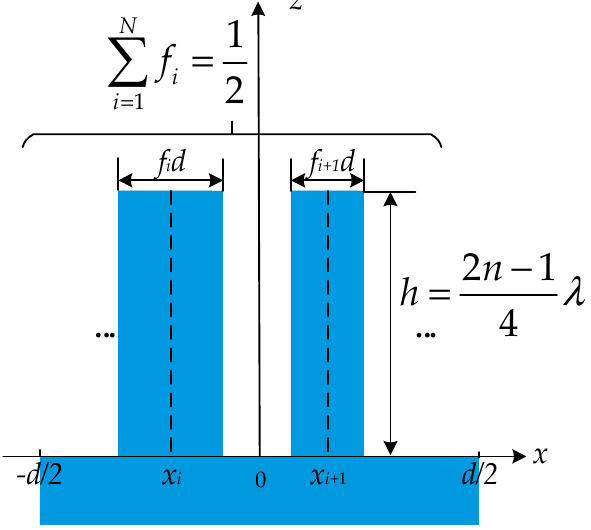
Figure 3. Segmented grating structure with the zeroth order eliminated. Except for the zeroth order, according to Equation (7), the diffraction field U (cid:48)(cid:48) m can be taken as the sum vector of the diffraction fields U ( m , i ) with different phase angles, as shown in Figure 4. According to Equation (8) and Equation (4), U ( m , i ) is obtained by rotating U m ∆ θ i = 2 m π x through an angle θ i between U ( m , i ) and U ( m , i +1) is: i / d . The angle m m